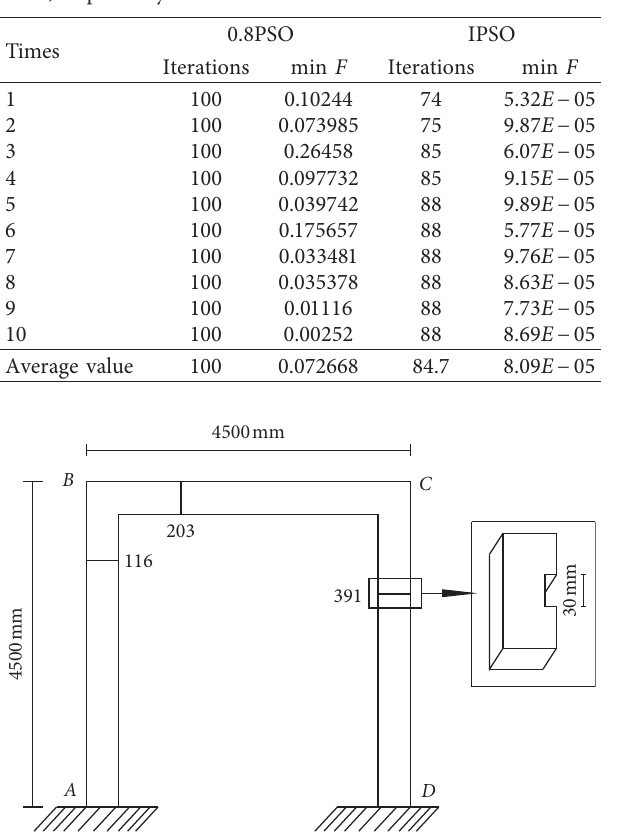
Figure 13: The relationship between the objective function and the iterations. (a) 0.8PSO. (b) IPSO. Table 1: Iterations and objective function values of 0.8PSO and IPSO, respectively.